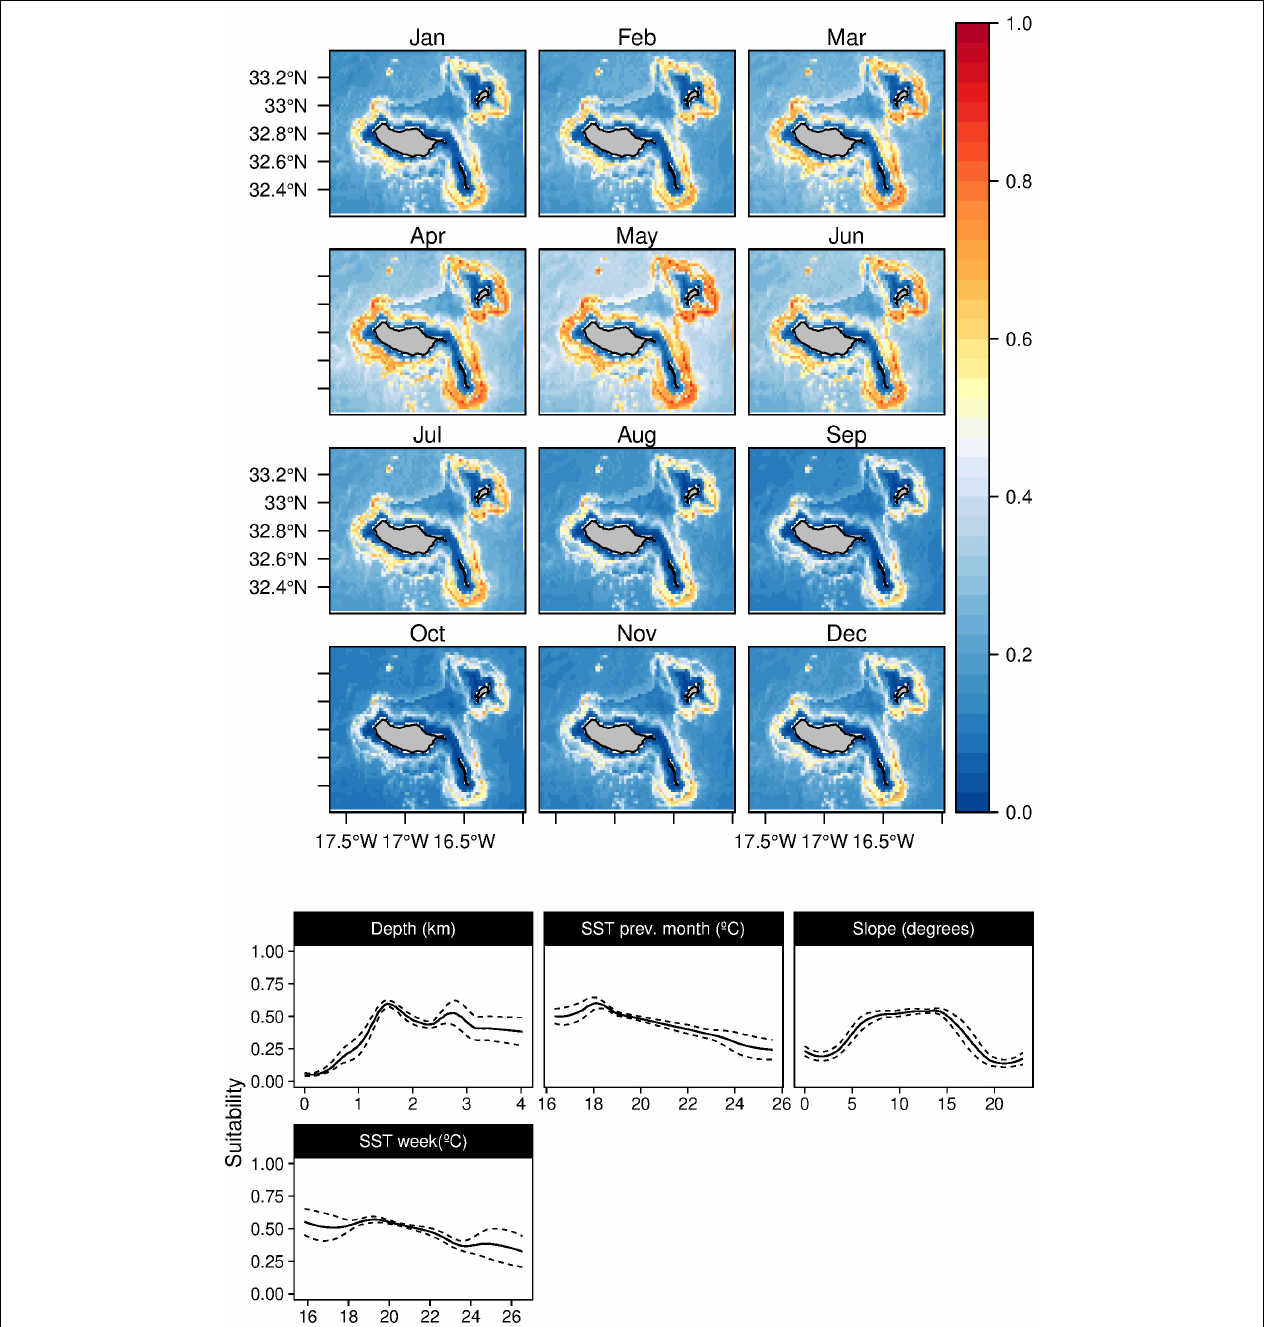
FIGURE 9 | Mean monthly suitability maps (above) and smoothed response curves with standard deviation (below) in the Madeira archipelago for Stenella coeruleoalba for the “8-days” models. In the maps, red represents more suitable and blue less suitable. Responses curves are ordered by percent contribution of the environmental